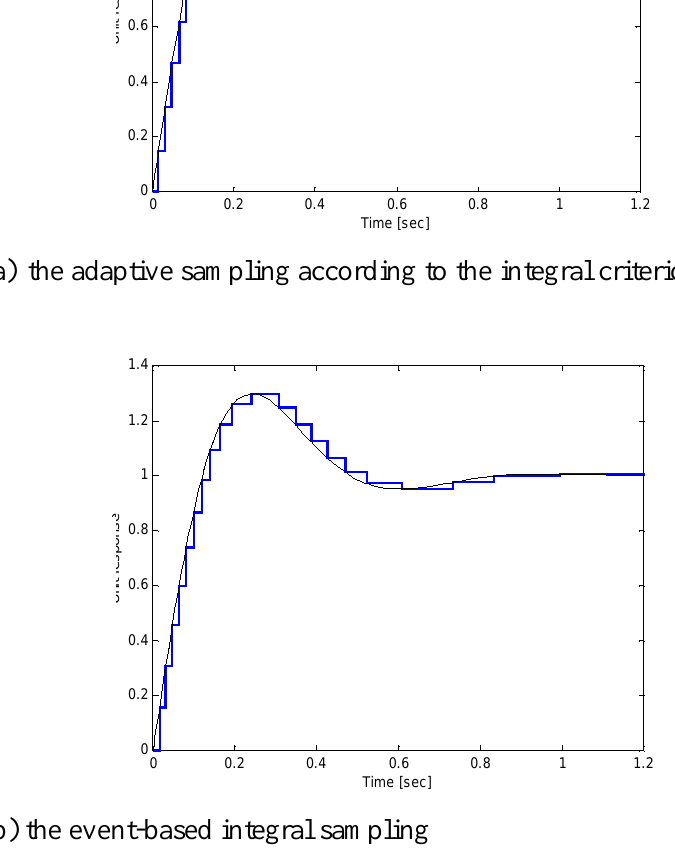
Figure 5. Comparison of the adaptive integral sampling (a), and the event-based integral one (b). The "local extremum trap" is illustrated in the adaptive sampling scheme (a). Note that the event-based scheme is immune to the such instability of the sampling error (b). Both sampling schemes are based on the constant integral-difference criterion with the same resolution. The sampled signal is the unit response of the second-order closed-loop system, the maximum sampling period in the adaptive sampling equals ]s[2.0 = T ; the zero-order hold is max